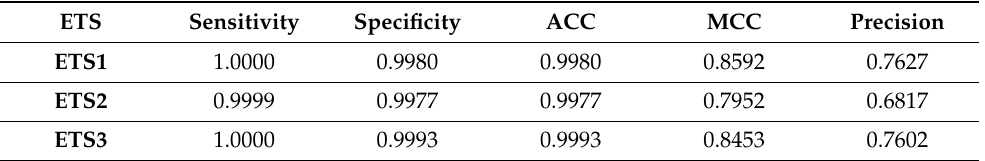
Table 3. Mean performance of machine learning classification combined with binarization obtained for external test sets